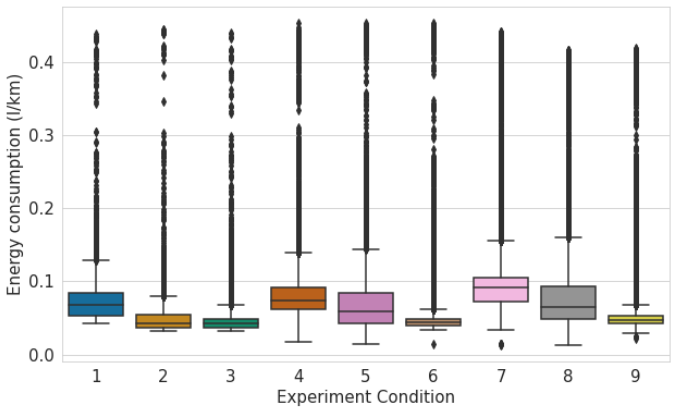
Figure 7. Box plots of energy consumption per kilometer (L/km) across all experiment